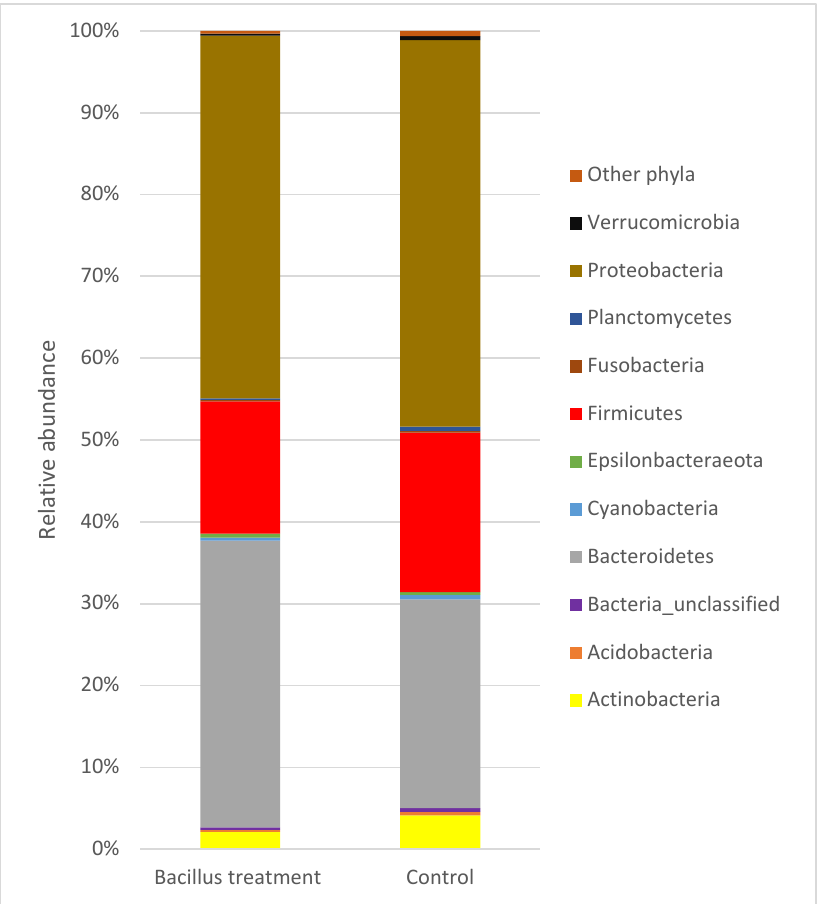
Figure 2. The relative abundances of taxa (at the phylum level) of leaf epiphytic bacteria from lettuce plants obtained from Bacillus probiotic treated and control aquaponic systems. Phyla less than 0.2% of the total reads are displayed under “other phyla” and include the phyla Armatimonadetes, Chloroflexi, Chlamydiae, Dependentiae, Nitrospirae, Patescibacteria, and Spirochaetes.